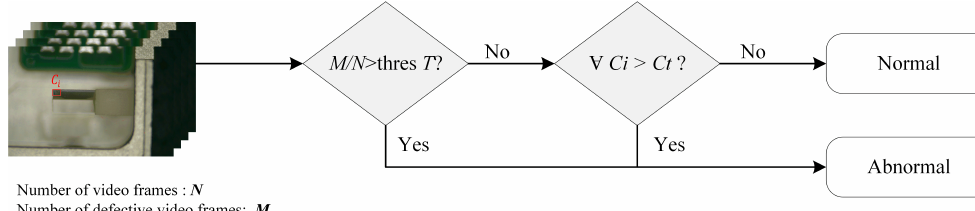
Figure 4. The video frames fusing module. N refers to the number of images framing from one video, M refers to the number of images where defects were detected. T is the threshold of the ratio between abnormal images and all images. C i refers to the confidence score of detected defects in the i th frame. The confidence threshold is set as C t . When M / N > T or C i > C t , the sample will be considered to